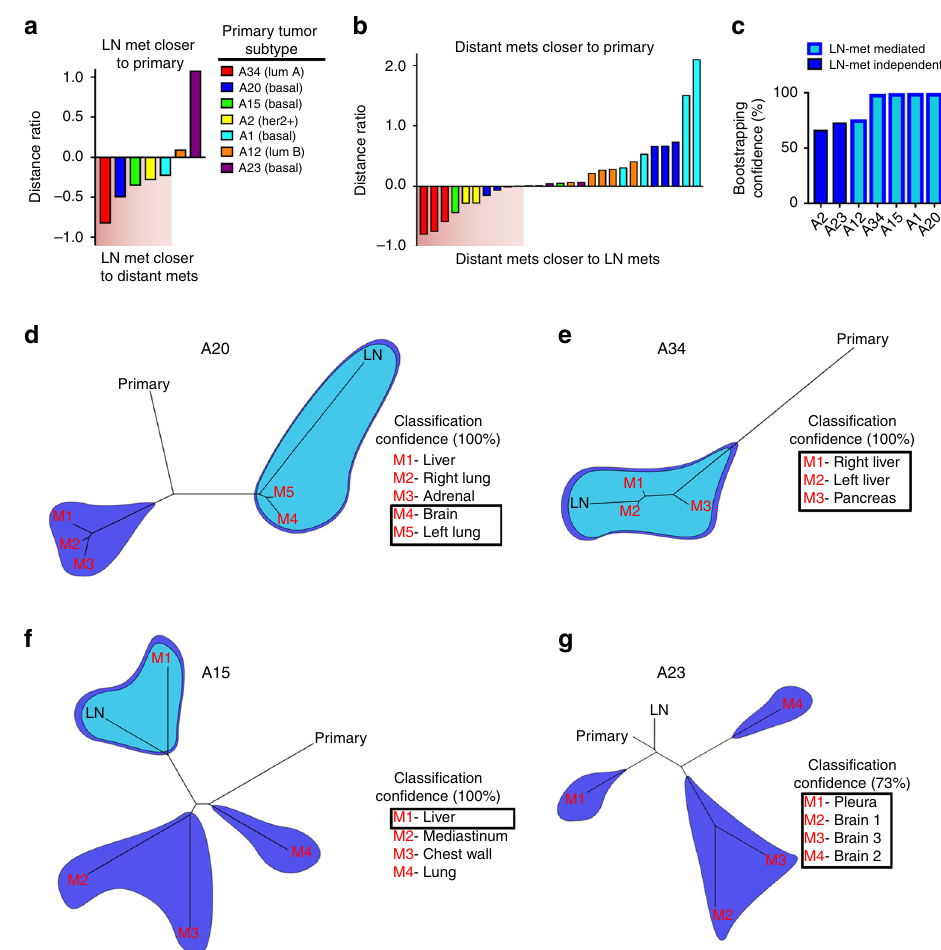
Fig. 1 Metastatic breast cancer patient phylogenetic analysis show that LN metastases ef fi ciently metastasize to distant organs. a Distance ratios from metastatic breast cancer patient samples on a patient and b individual metastasis basis. c Bootstrap con fi dence estimates for each group of patient samples. d – f Representative patient phylogenetic trees showing examples of LN-met- mediated and g LN-met-independent patterns of spread. Light blue shading demarcates LN-containing clades, whereas dark blue shading demarcates distant metastasis clades. Overlapping shading indicates clades containing both LN and distant metastases, implicating a LN-mediated pattern of distant metastases. Boxed in metastasis are those displaying a LN- mediated pattern of